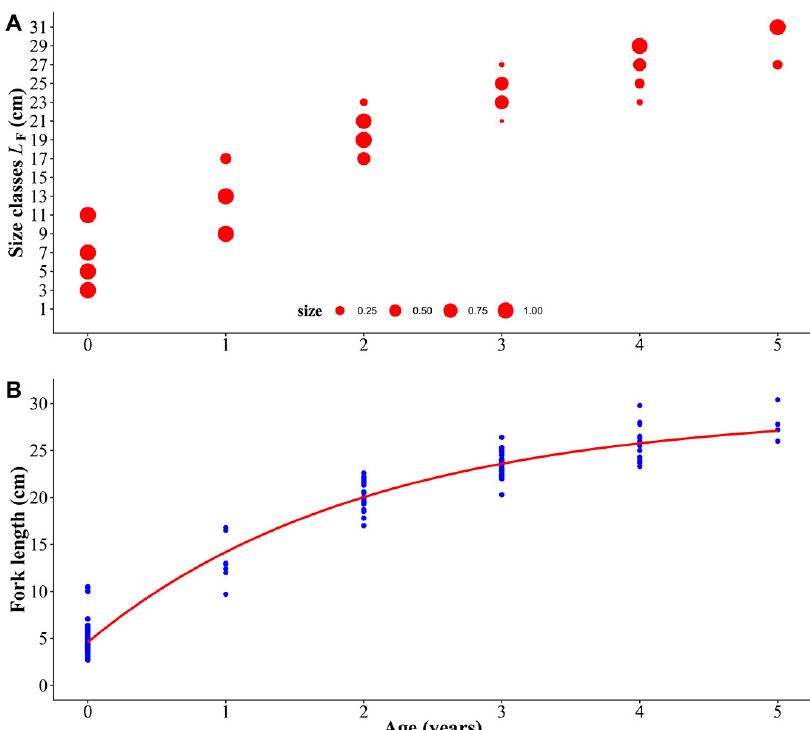
Fig. 5. – Graphical representation of age-length key (A) and von Bertalanffy growth model (B) using age estimated from otolith data (n=225). Bubble plot circles (A) represent the proportions of fish length intervals at a given age. Blue dots (B) in the growth model are the observed ages at a specific length, and the red line is the best-fitting